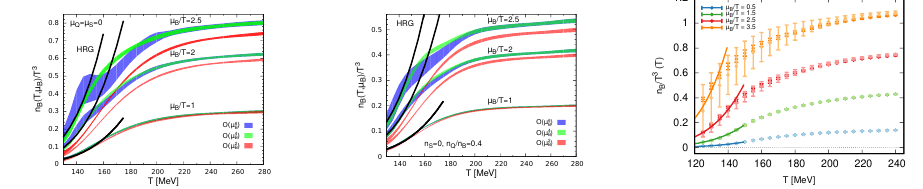
B / M ( T ,µ B ) = S B σ 3 ( T ,µ B ) = κ B σ 2 as a function Figure 4. (Ref. [27]) Left: The ratios R B B and R B B 31 42 of R B ( T ,µ B ) = M B /σ 2 evaluated along the transition line in comparison to the data from the STAR B 12 collaboration (Ref. [29, 30]). Right: The ratios R B ( T ,µ B ) and R B ( T ,µ B ) as a function of R B ( T ,µ B ) in 12 51 62 comparison to the data from the STAR collaboration (Ref. [30]).